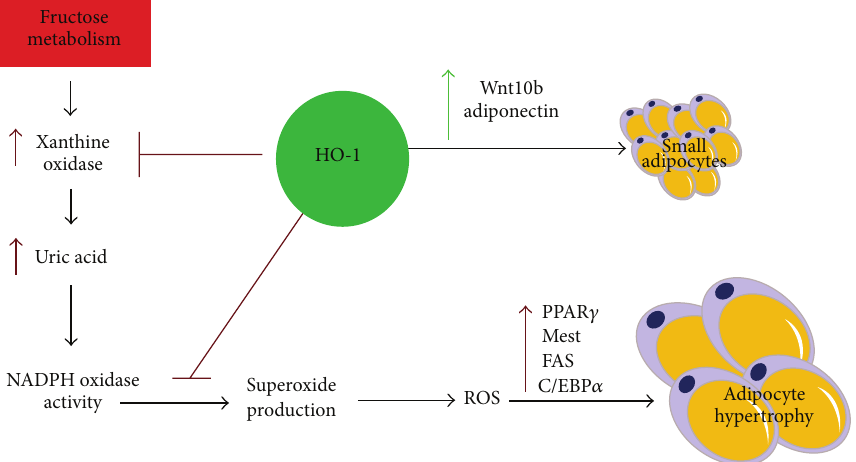
Figure 8: Proposed mechanism demonstrating the beneficial role of heme oxygenase 1 (HO-1) in the attenuation of adipocyte dysfunction in mesenchymal stem cell- (MSC-) derived adipocytes. Excessive fructose consumption is accompanied by an increase in xanthine oxidase and uric acid and a concurrent increase in cellular ROS levels. HO-1 suppresses adipocyte differentiation by increasing expression of key regulators including Wnt10b and adiponectin and decreasing expression of adipogenic transcription factors CCAAT/enhancer binding protein 𝛼 (C/EBP 𝛼 ), peroxisome proliferator-activated receptor 𝛾 (PPAR 𝛾 ), Mest, and FAS. These effects led to decrease in lipid accumulation and increase of preadipocytes and healthy adipocytes that improve adipocyte